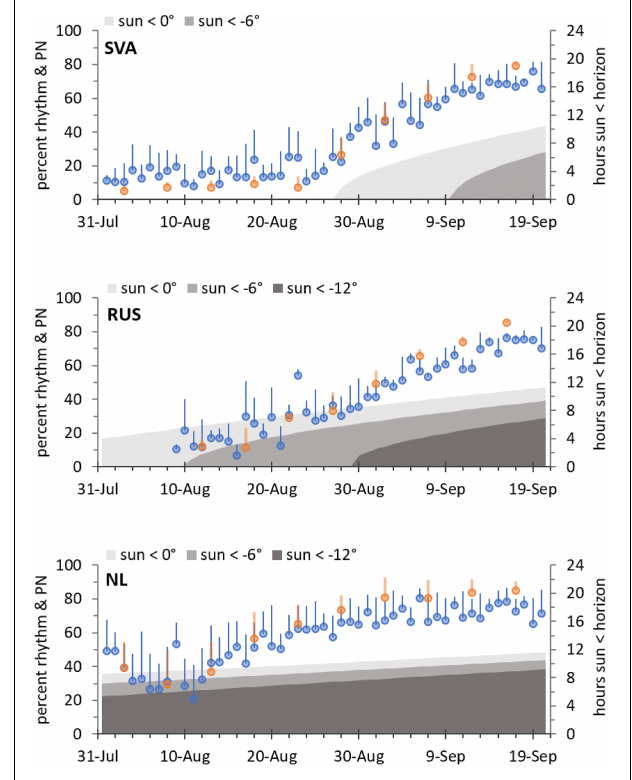
FIGURE 4 | Course of local photoperiod and circadian rhythmicity of Tb in barnacle geese at the end of summer while staying in Svalbard (SVA), in Russia (RUS), or in the Netherlands (NL). Plotted are percent rhythm (mean + SD over individuals, blue symbols) calculated from daily cosinor analysis, and normalized power (PN, mean + SD over individuals, orange symbols) at a period length of 24 h calculated from Lomb-Scargle periodogram analyses on 5-day intervals (both left axis). The amount of time the sun was at certain angles below horizon (right axis) is shown by shades of grey representing categories of, respectively, civil twilight, nautical twilight, and